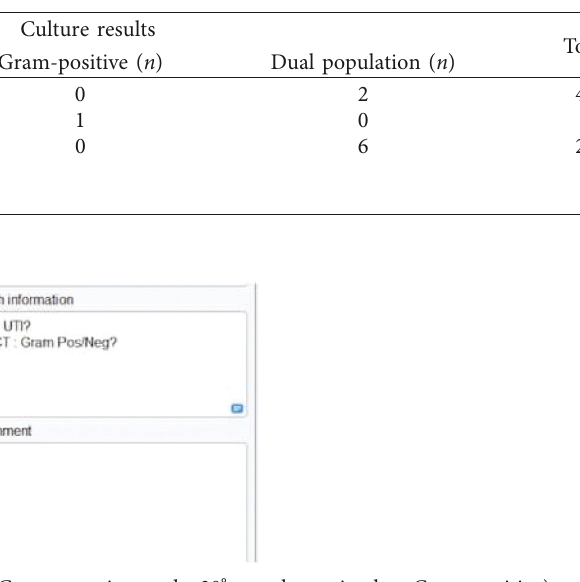
Table 4: Agreement between BACT flagging and the urine culture result.